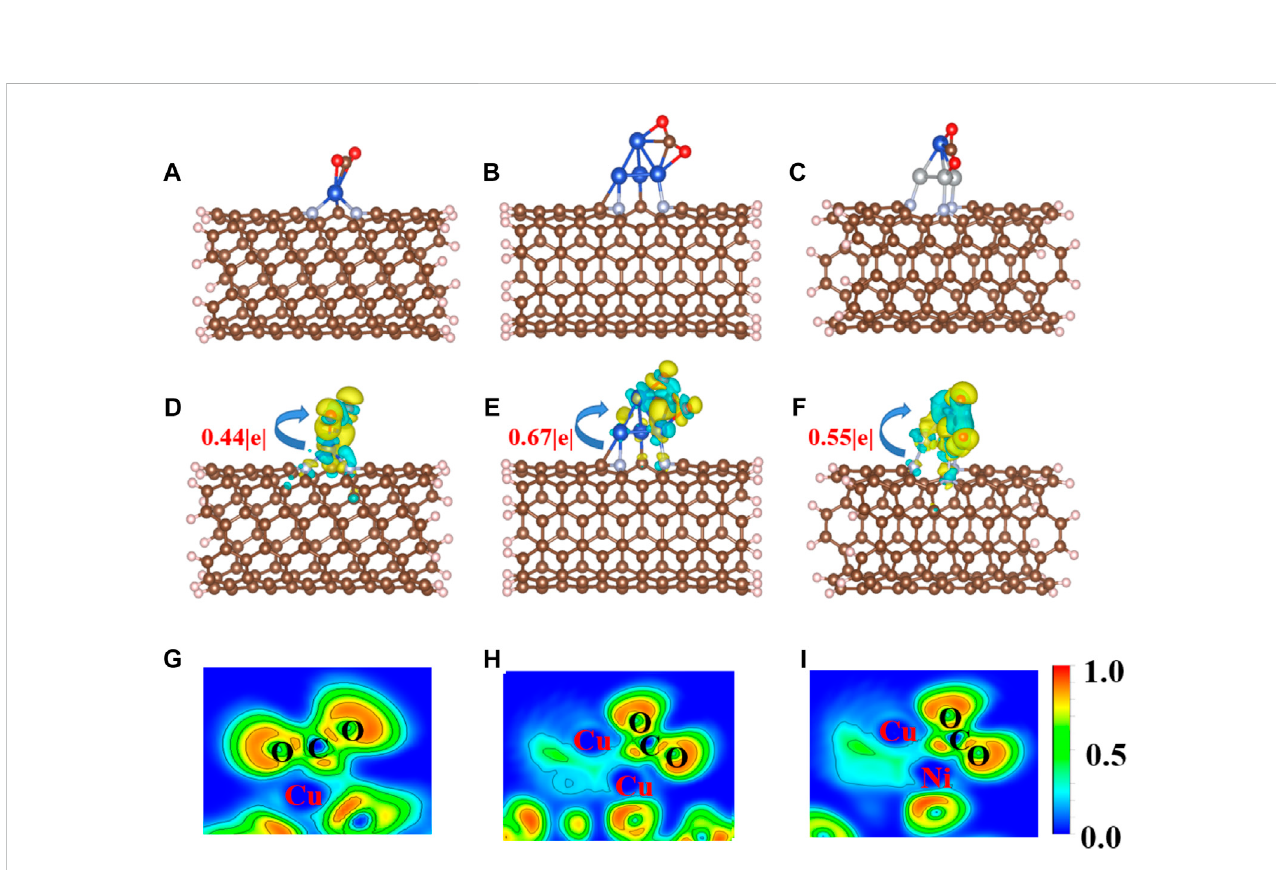
FIGURE 2 (A – C) Optimized adsorption con fi gurations of CO (D – F) Calculated charge density difference (CDD) and 2 on Cu@CNTs, Cu 4 @CNTs, and CuNi 3 @CNTs. (G – I) theelectroniclocalfunctiondiagram(ELF)ofCO 2 adsorption.Thechargedepletionandaccumulationaredepictedinblueandyellow,respectively.The equivalent face value is 0.005 e/Å – 3